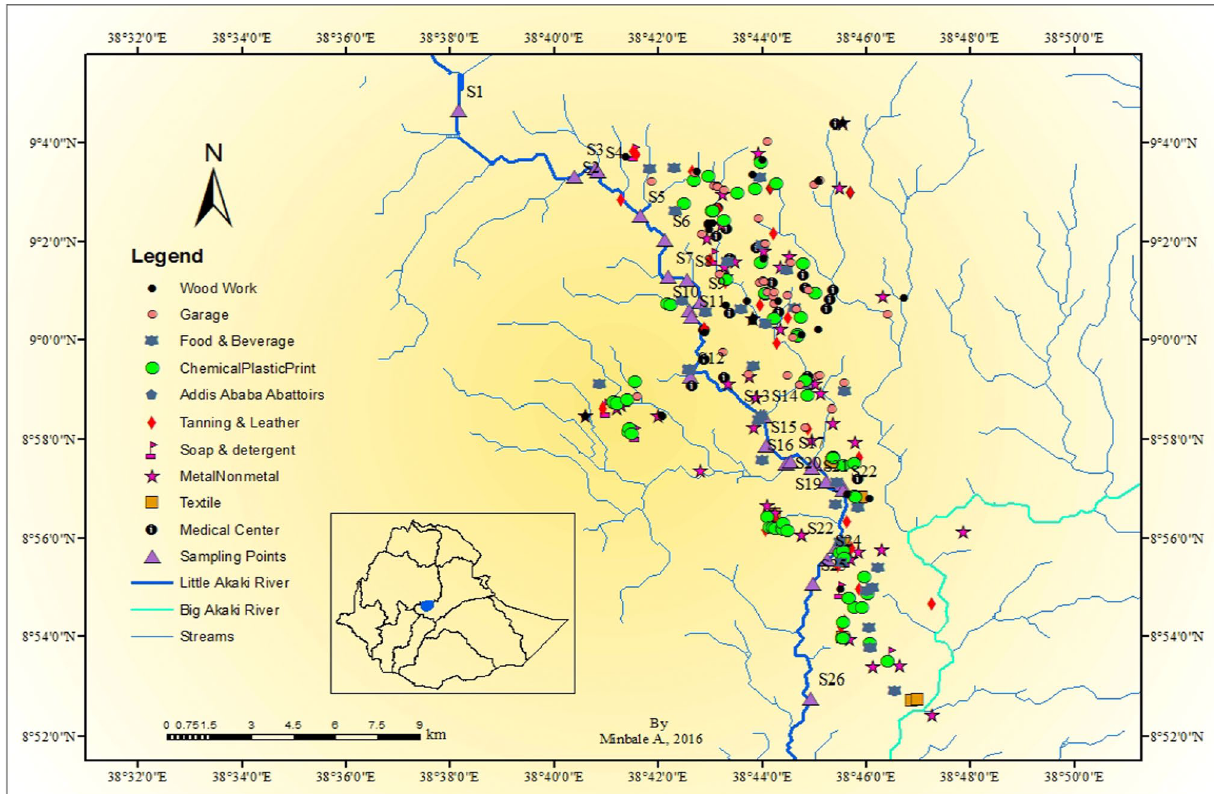
Fig. 1 Location of sampling sites, various industries and other potential sources of